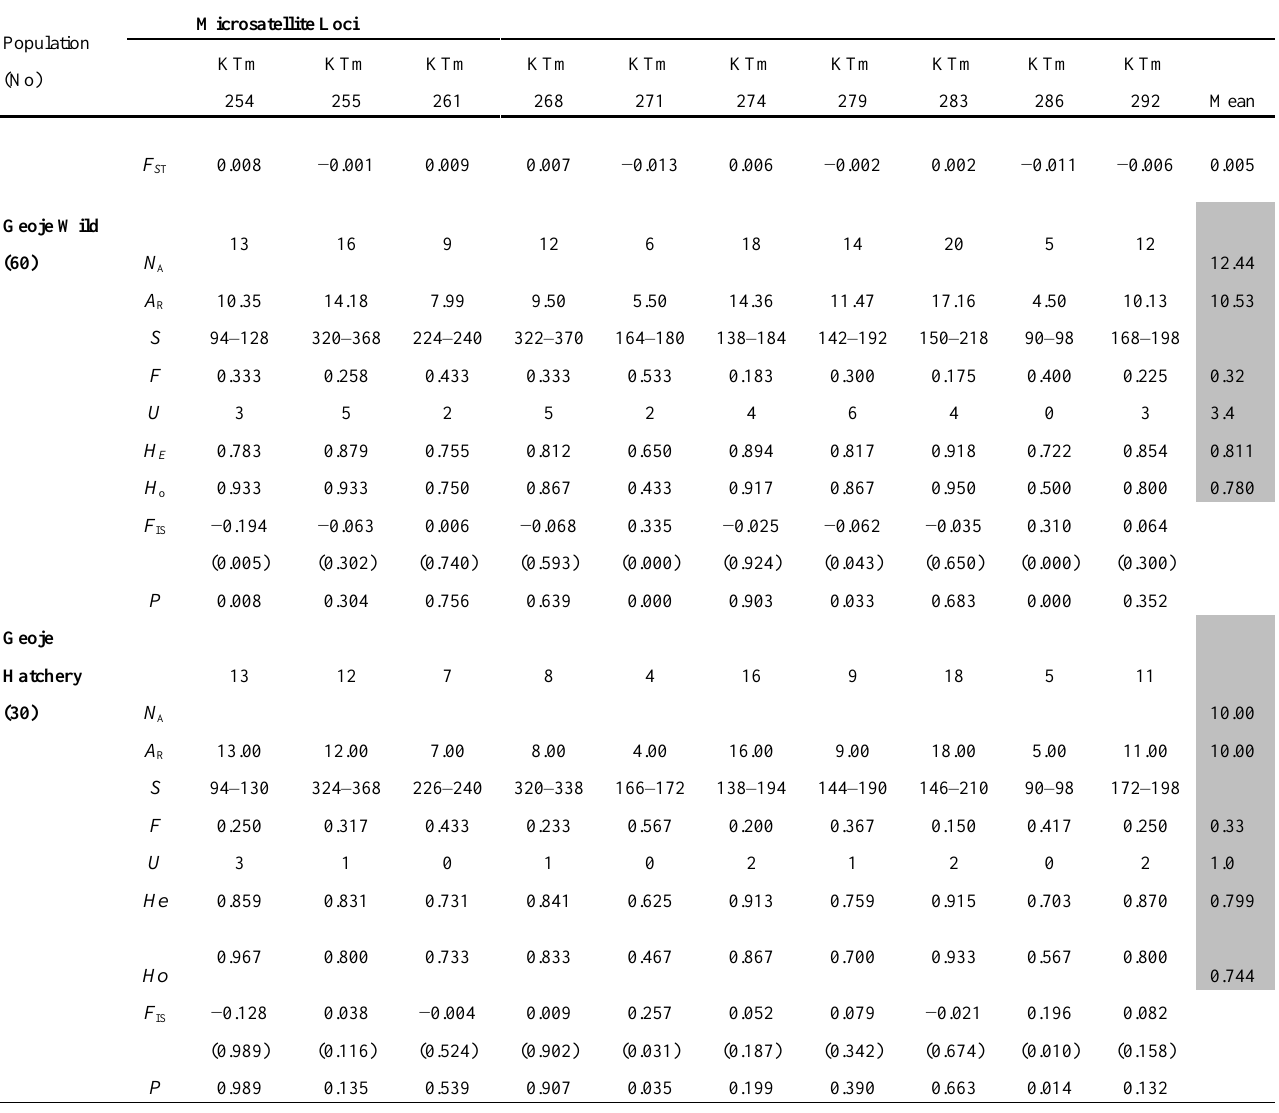
Single-locus F ST , number of samples ( N o ), number of alleles per locus ( N A ), allellic richness ( A R ), size in bp of alleles ( S ), frequency ( F ) of the most common allele, number of unique alleles ( U ), expected heterozygosity ( H E ), observed heterozygosity ( H o ), inbreeding coefficient ( F IS ), and probability of significant deviation from Hardy-Weinberg equibrium after Bonferroni correction ( P , initial α = 0.05/20 = 0.003) are given for each population and locus. Calculations assume that individuals with one microsatellite band are homozygous for the allele. Number in parenthesis below F IS indicates the probability of significant heterozygosity excess or